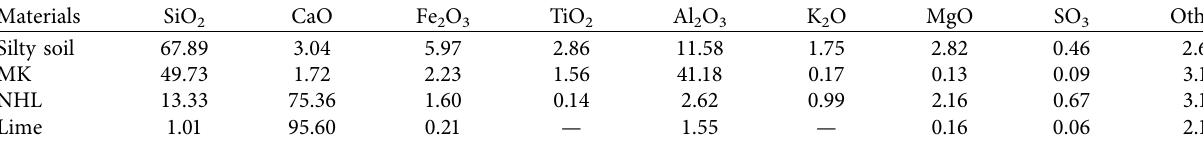
Table 2: Main components of silty soil, lime, metakaolin, and hydraulic lime.